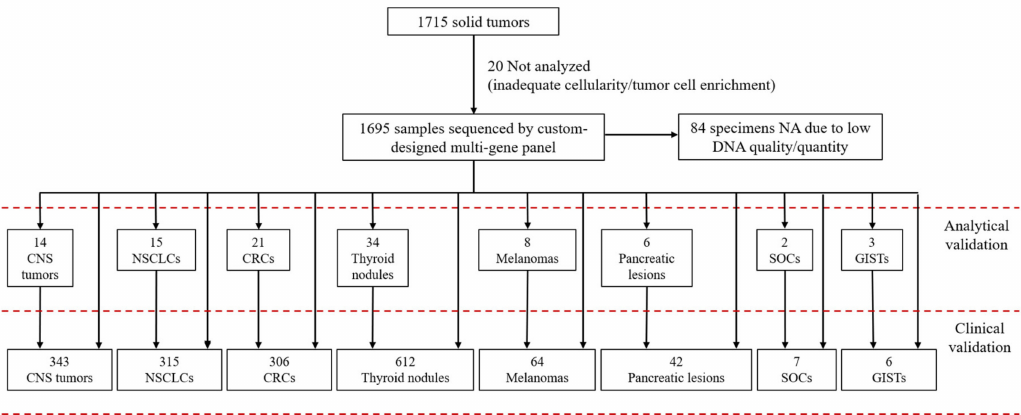
Figure 1. Cases analyzed by the custom-designed multi-gene panel. CNS: central nervous system / intracranial; NSCLCs: non-small cell lung carcinomas; CRCs: colorectal carcinomas; SOCs: squamousoralcarcinomas; GISTs: gastrointestinalstromaltumors; NAnotassessable: